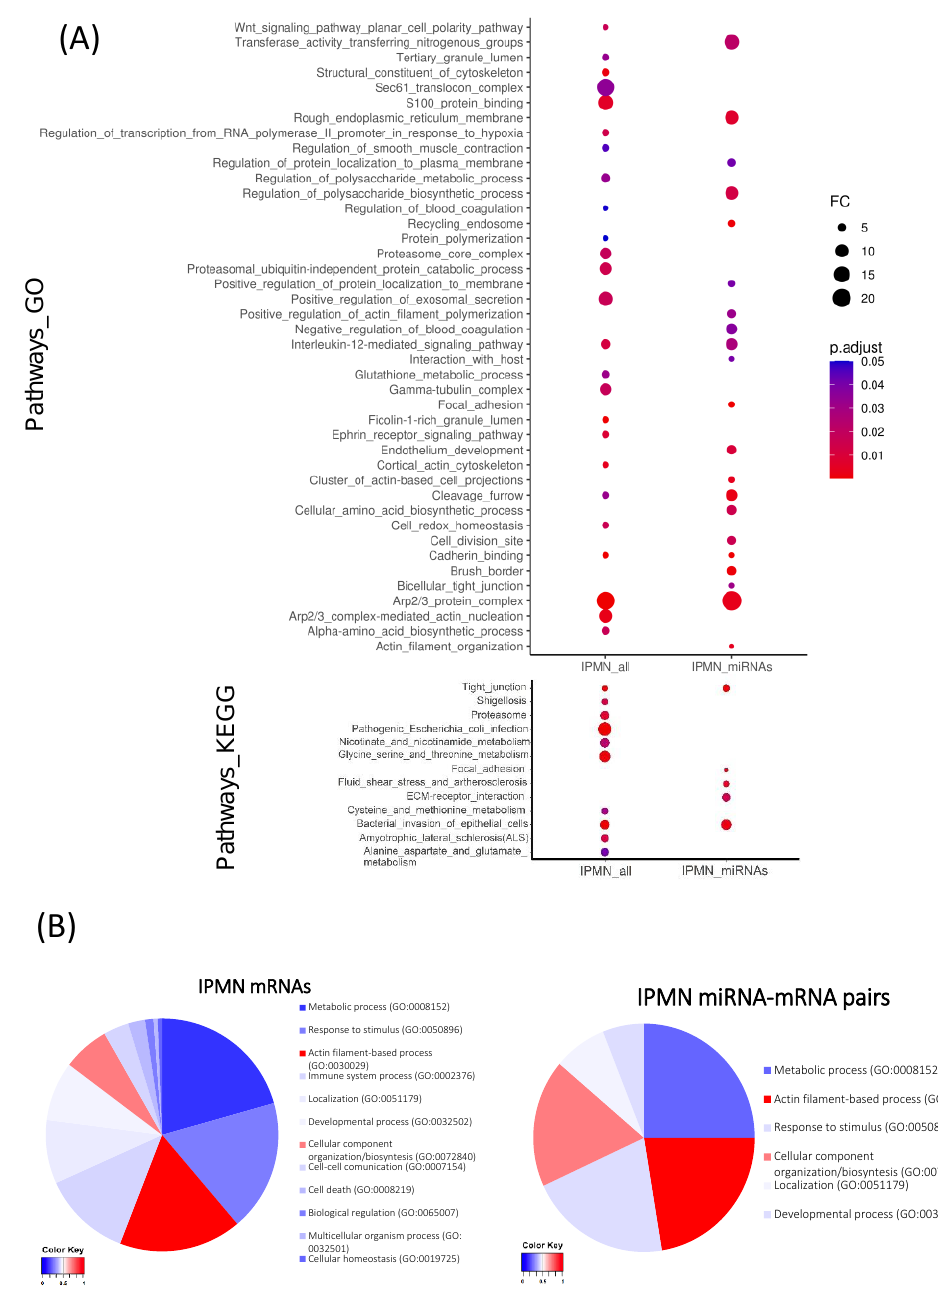
Figure 3. In silico functional analysis of miRNA-mRNA interactions predicted by miRComb in IPMN. ( A ) Dot plot showing comparative pathway enrichment analysis from all deregulated mRNAs in IPMN samples (IPMN_all) and from only those mRNAs paired with miRNAs in our model (IPMN_miRNAs); adj p -value < 0.05; FC > 4. Gene Ontology analysis (Biological process, Cellular component, Molecular function) plus KEGG pathways results are shown. ( B ) Pie charts representing functional analysis from all differentially expressed mRNAs in IPMN (left), and from only those miRNA paired mRNAs in IPMN (right). The represented data come from Gene Ontology Biological Process report. Gradient for distribution of genes related with cell structure (cytoskeleton GO:0005856, cell adhesion GO:0007155 and extracellular matrix GO:0043062), among enriched pathways. Scores correspond to the normalized proportion of cell structure proteins from our dataset in each enriched pathways. Scores: Maximum 1 (red) minimum 0